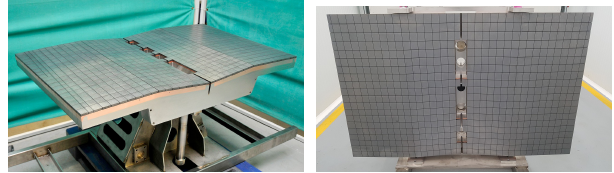
Figure 8. Prototype panel for the FW manufactured by Framatome. Reprinted from Ref.